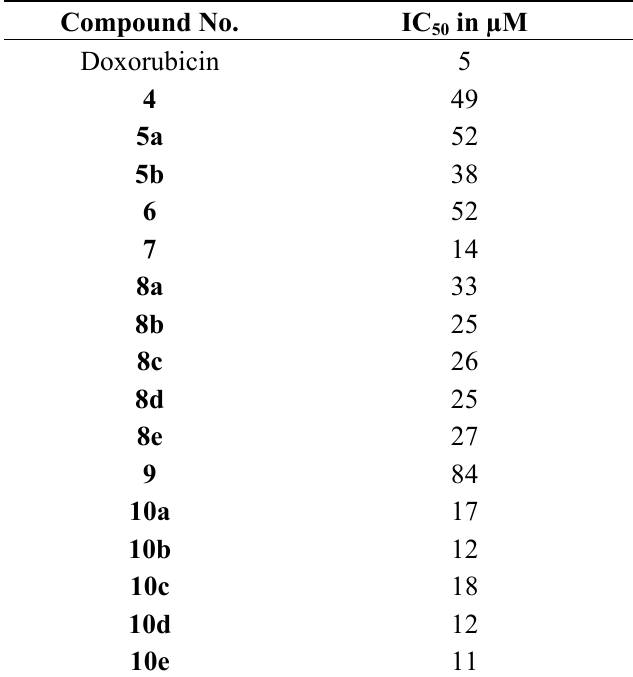
Table 1. Results of in vitro cytotoxic activity of the synthesized compounds on human breast cancer cell line